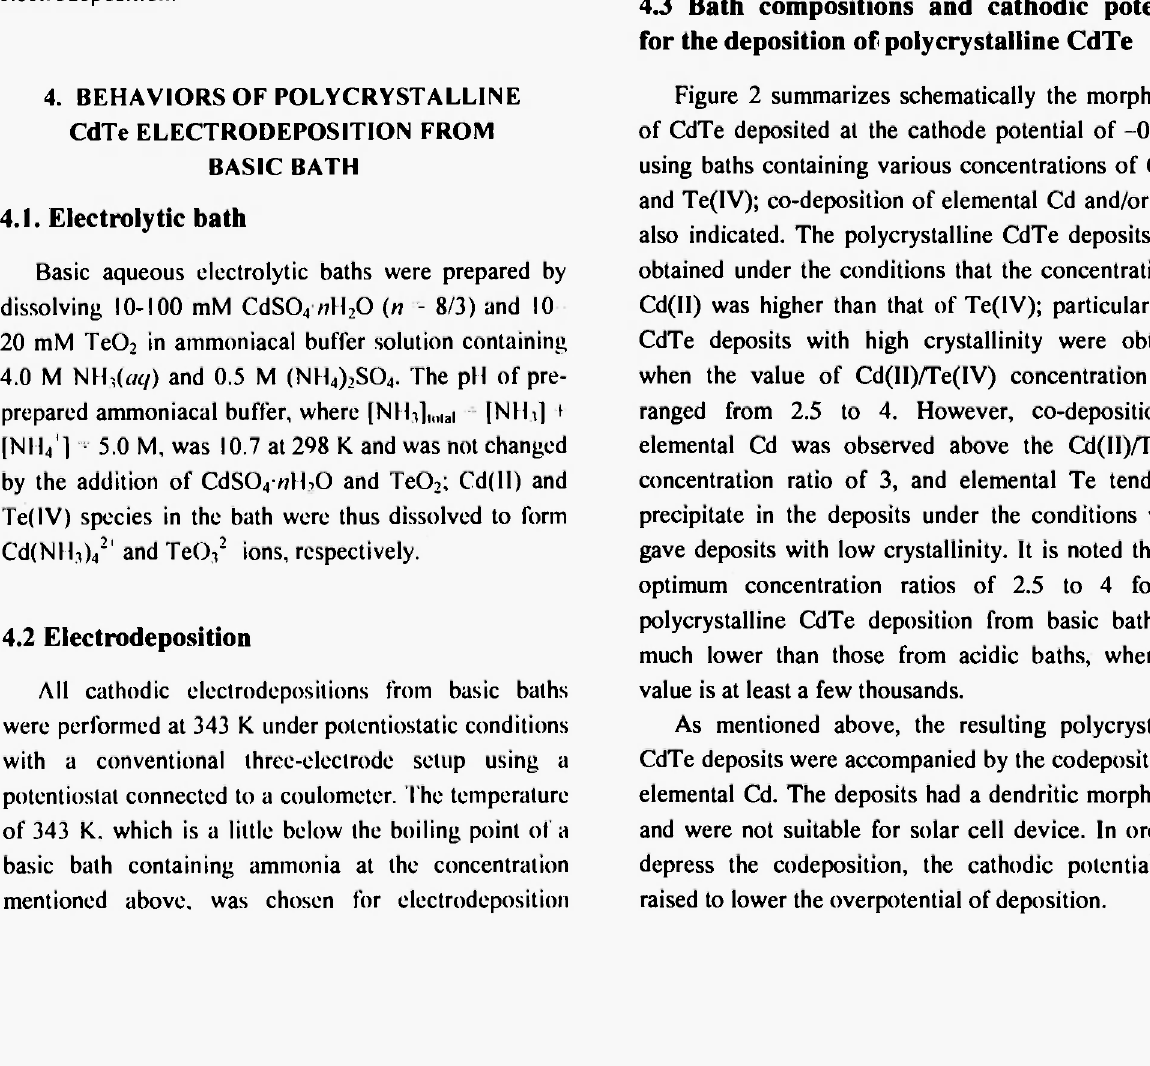
are also considered to be suitable for CdTe